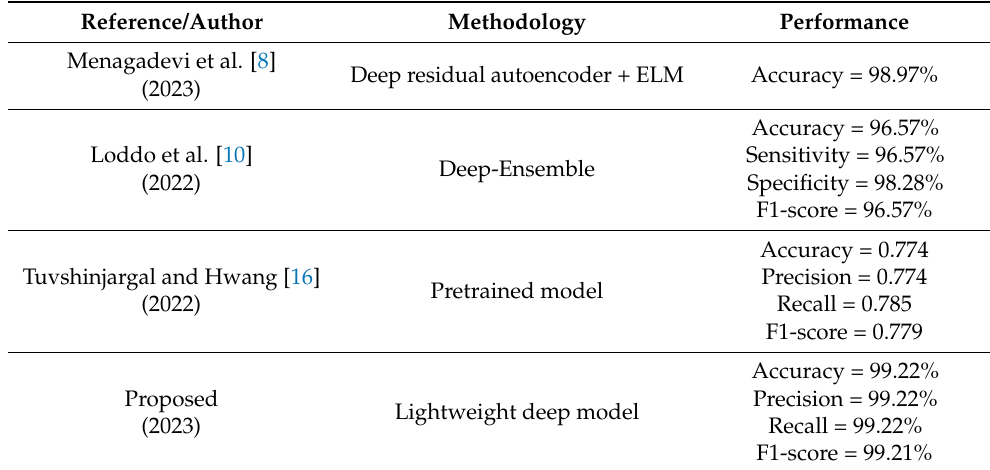
Table 6. Comparison between the proposed model with other previous model for binary classification task.